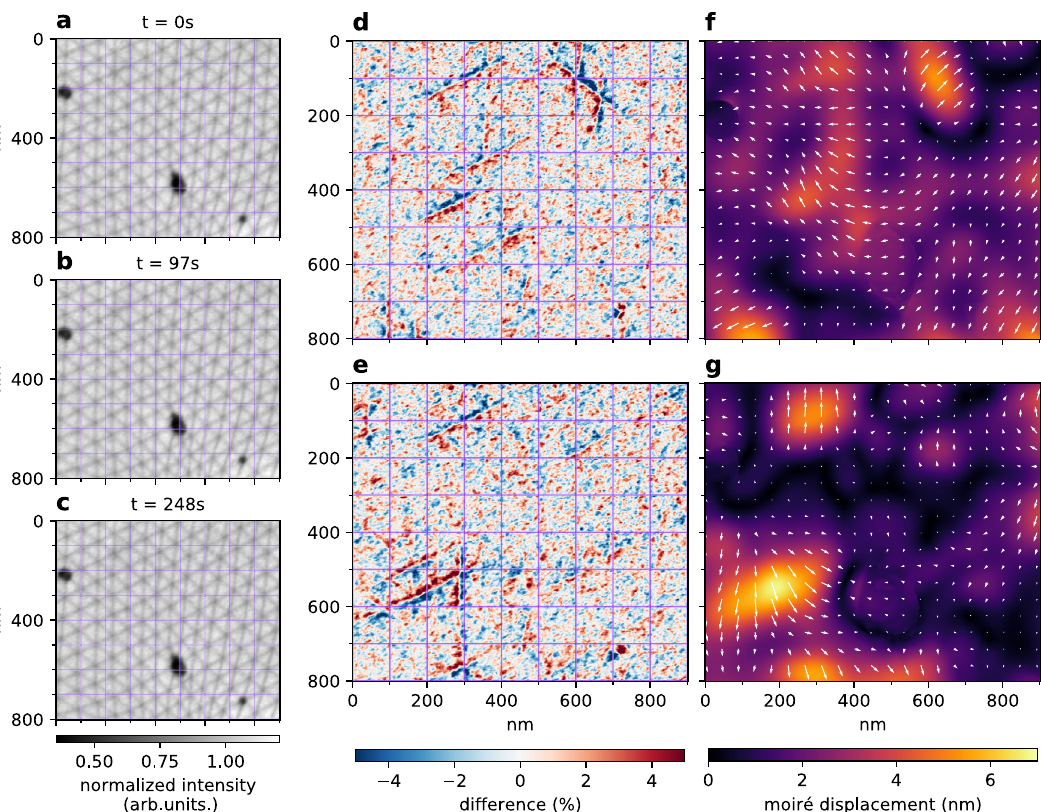
Fig. 4 Dynamics of moiré patterns. a – c Three images of the same area (in the same domain as Fig. 1f), taken minutes apart at a constant temperature of 500 °C. Here, θ * ≈ 0.18 and ϵ ≈ 0.04% (local values as extracted by GPA shown in Supplementary Fig. 4). d , e Difference of respectively b and c with a , i.e., t = 0 s, highlighting the shift of the domain boundaries. f , g GPA extracted displacement of respectively b and c with respect to t = 0 s, with the arrows indicating the direction and amplitude, magni fi ed eight times for